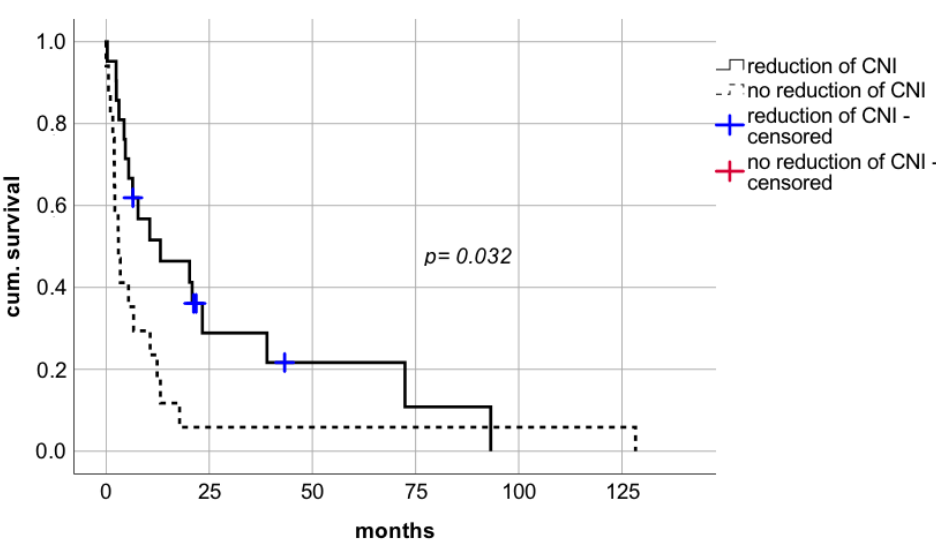
Figure 6. Impact on modification of immunosuppressive therapy in patients with palliative treatment after diagnosis of de novo lung carcinoma after liver transplantation. CNI—calcineurin